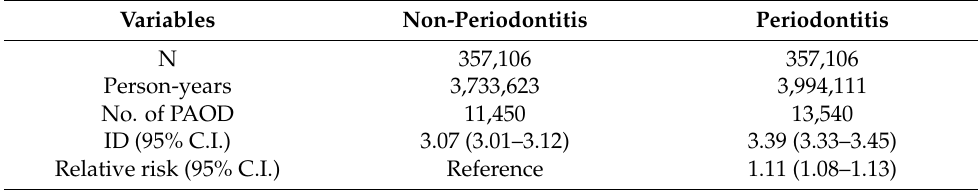
Table 2. Poisson regression of relative risk of PAOD between periodontitis and non-periodontitis.